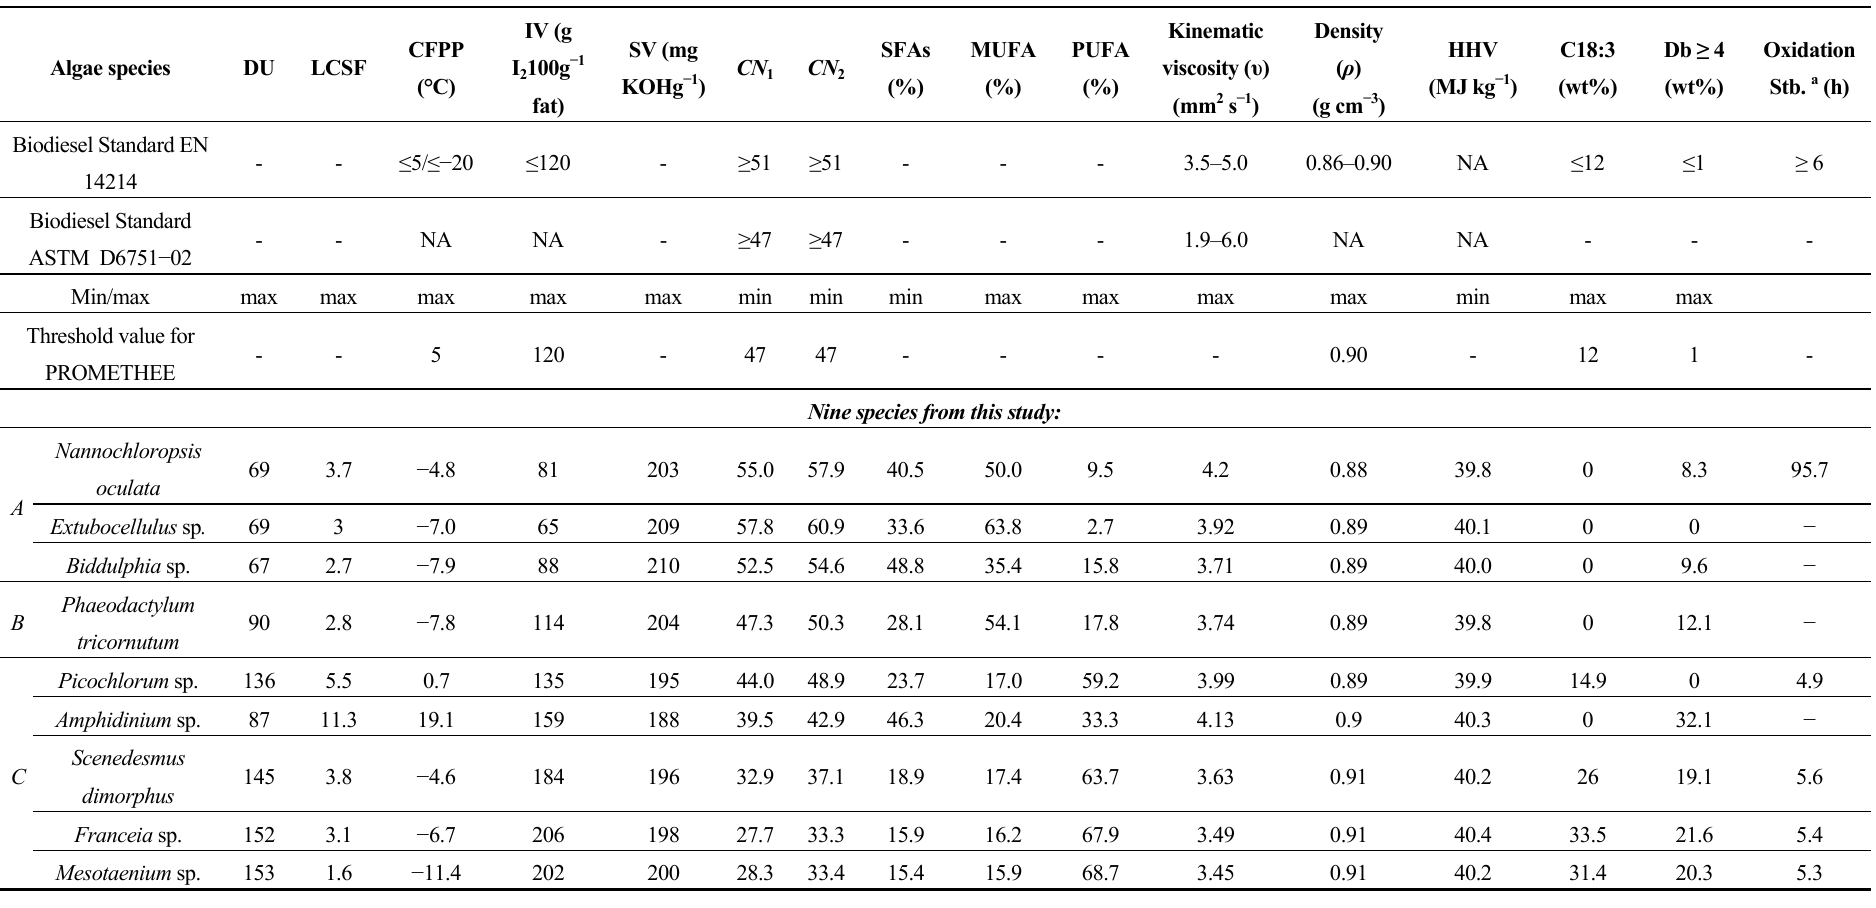
Table 3. Biodiesel properties calculated from the FAME profile of nine microalgal species (this study) and twelve species from [12]. Algae species DU Biodiesel Standard EN 14214 Biodiesel Standard